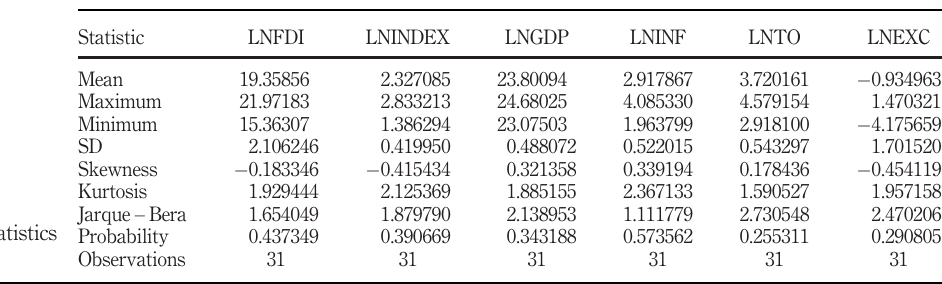
Table A1. De fi nition